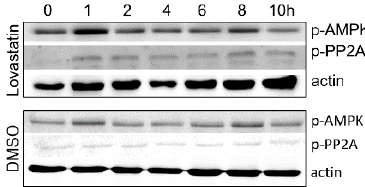
Figure 2. Inhibition of HMGCR by lovastatin has no effect on the activity of AMPK and PP2A during PCV2 infection. Cells were treated with lovastatin (20 µ M) or 0.5% DMSO and infected with PCV2, then analyzed by western blot at the indicated time points. The experiments were repeated at least three times.